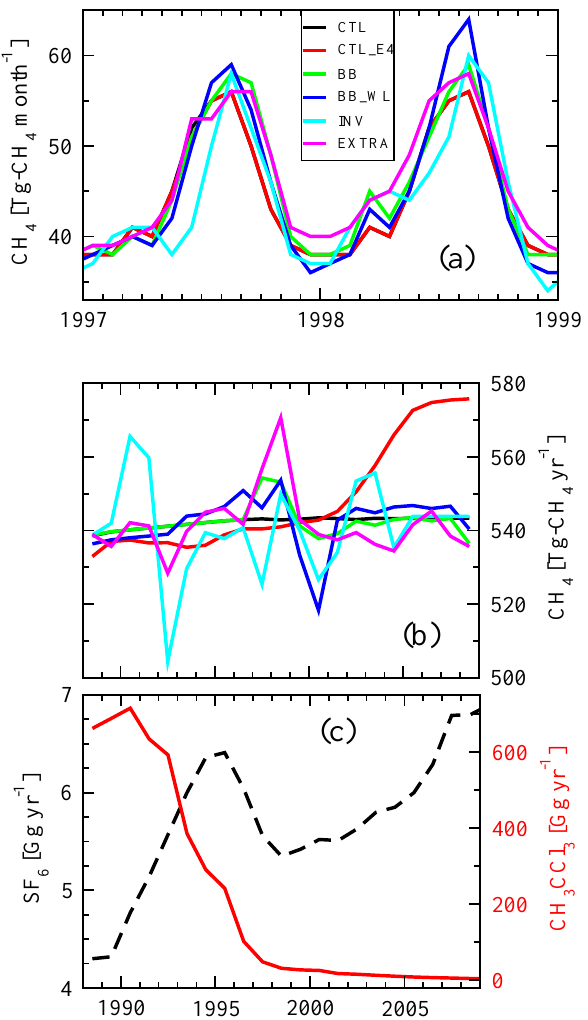
Fig. 2. Examples of CH 4 emission seasonalities corresponding to the years 1997 and 1998 are shown in (a) (the black line is hidden behind the red line), and annual mean CH 4 emissions for the pe- riod of 1988–2008 are depicted in (b) . The annual mean SF 6 and CH 3 CCl 3 fluxes are shown in (c)